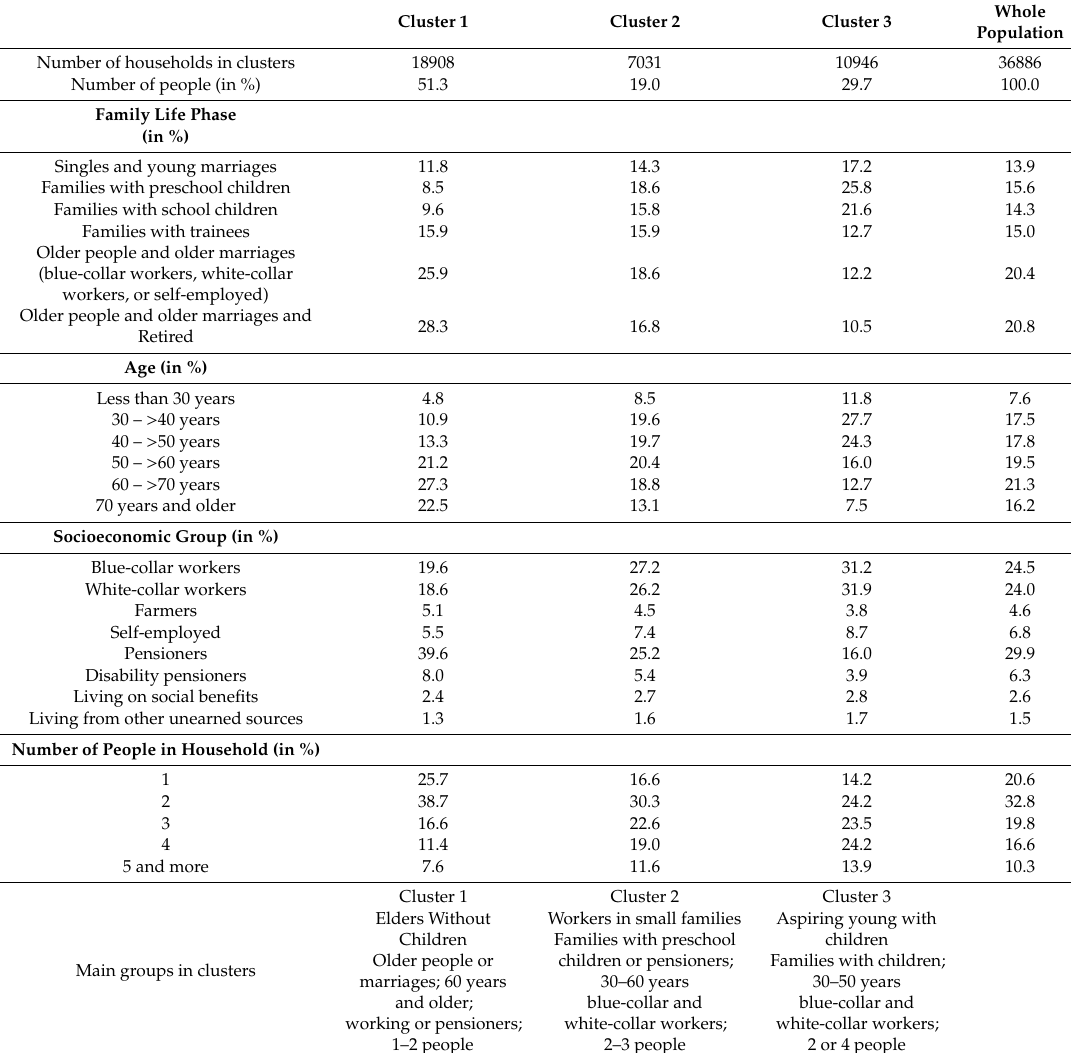
Table 3. Cluster